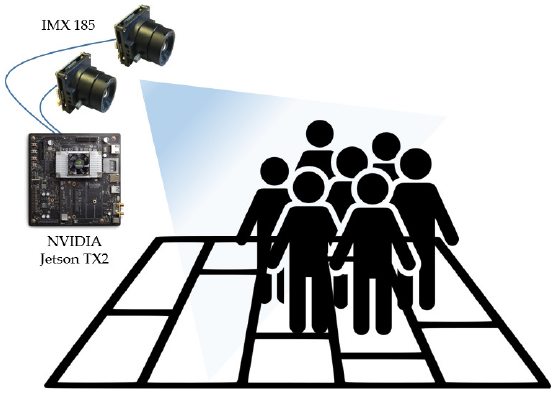
Figure 1. The schematic concept of the proposed method.